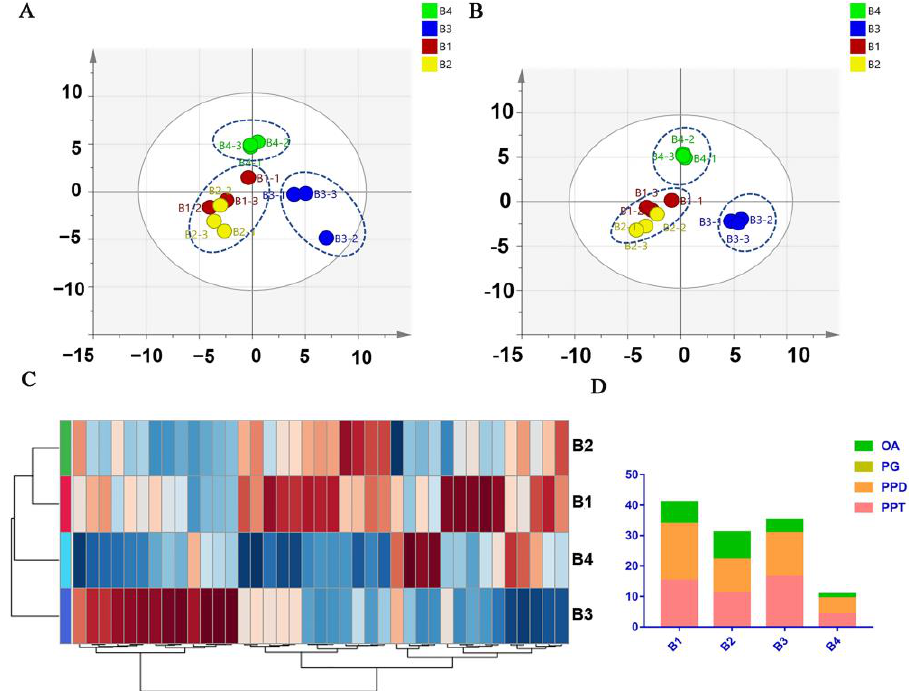
Figure 5. Multivariate statistical analysis of the P. ginseng samples. ( A ) PCA analysis. ( B ) OPLS-DA analysis. ( C ) heatmap. ( D ) The total content of each type of saponin.